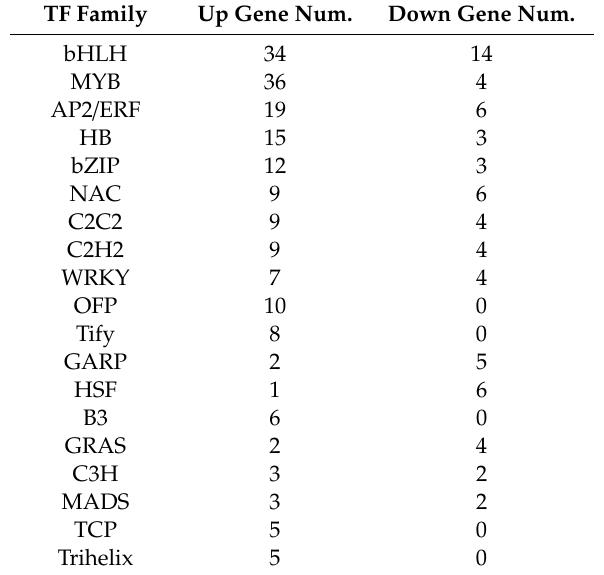
Table 4. The TF family and their contained dysregulated gene number. TF Family Up Gene Num. Down Gene Num.